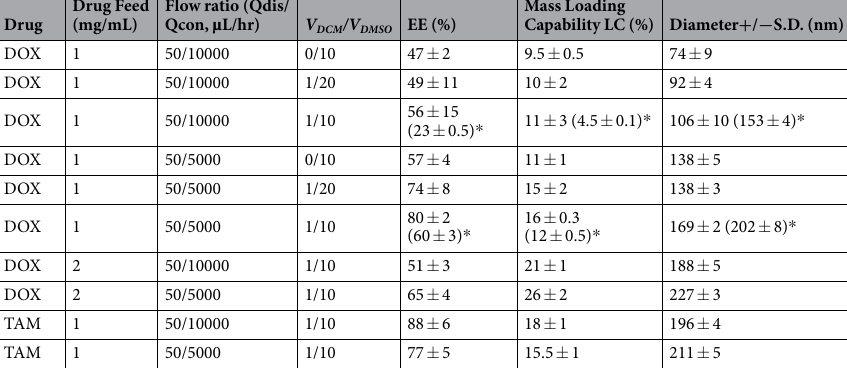
Table 2. Comparison of drug encapsulation efficiency (EE) and loading capability (LC) of PLGA NPs prepared at different flowrate ratios, compositions V DCM /V DMSO , and initial feeding drug concentrations. Concentration of PLGA (Mw = 4000~15000 g/mol) = 5 mg/mL. Asterisk symbol represents data by bulk method with same parameters. (n = 3; mean ±